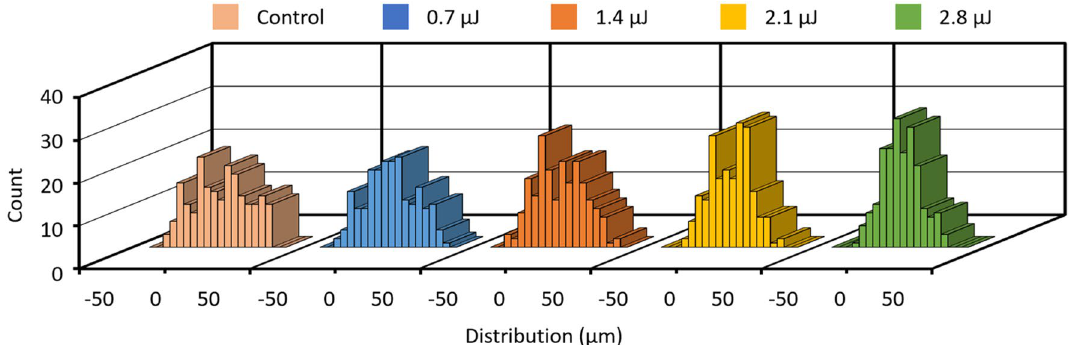
Figure 5. The performance of focusing 10-µm polystyrene particles using the open v-shaped microstructures achieved by femtosecond pulse laser at different energies of 0 (control), 0.7, 1.4, 2.1 and 2.8 µJ/pulse.